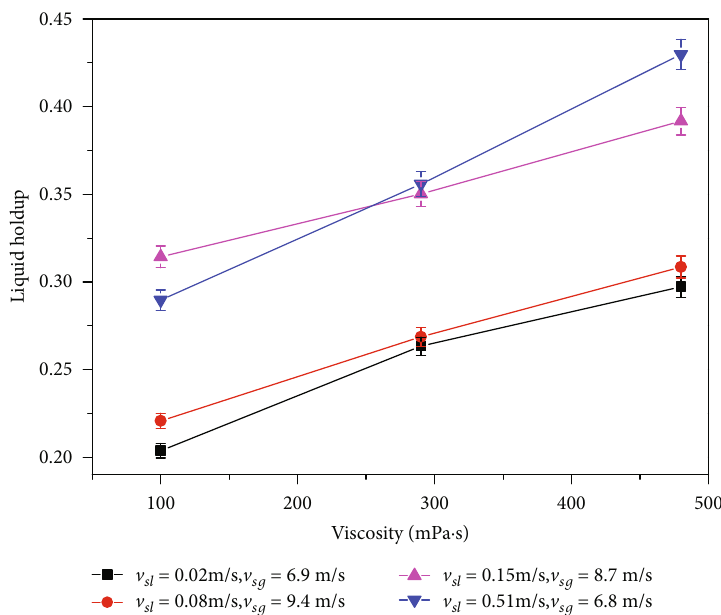
Figure 3: Liquid holdup vs. liquid viscosity in the air-oil experiment.